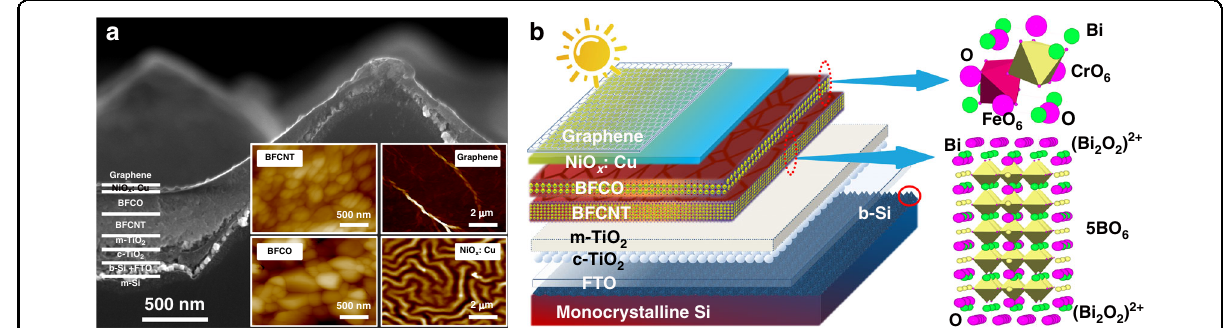
Fig. 1 Microstructure and crystal texture. a SEM images of both the full device stack and the individual layers of BFCNT, BFCO, graphene, and NiO x : Cu. b Schematic of the multiferroic solar cells and the unit cell structures of both BFCNT and